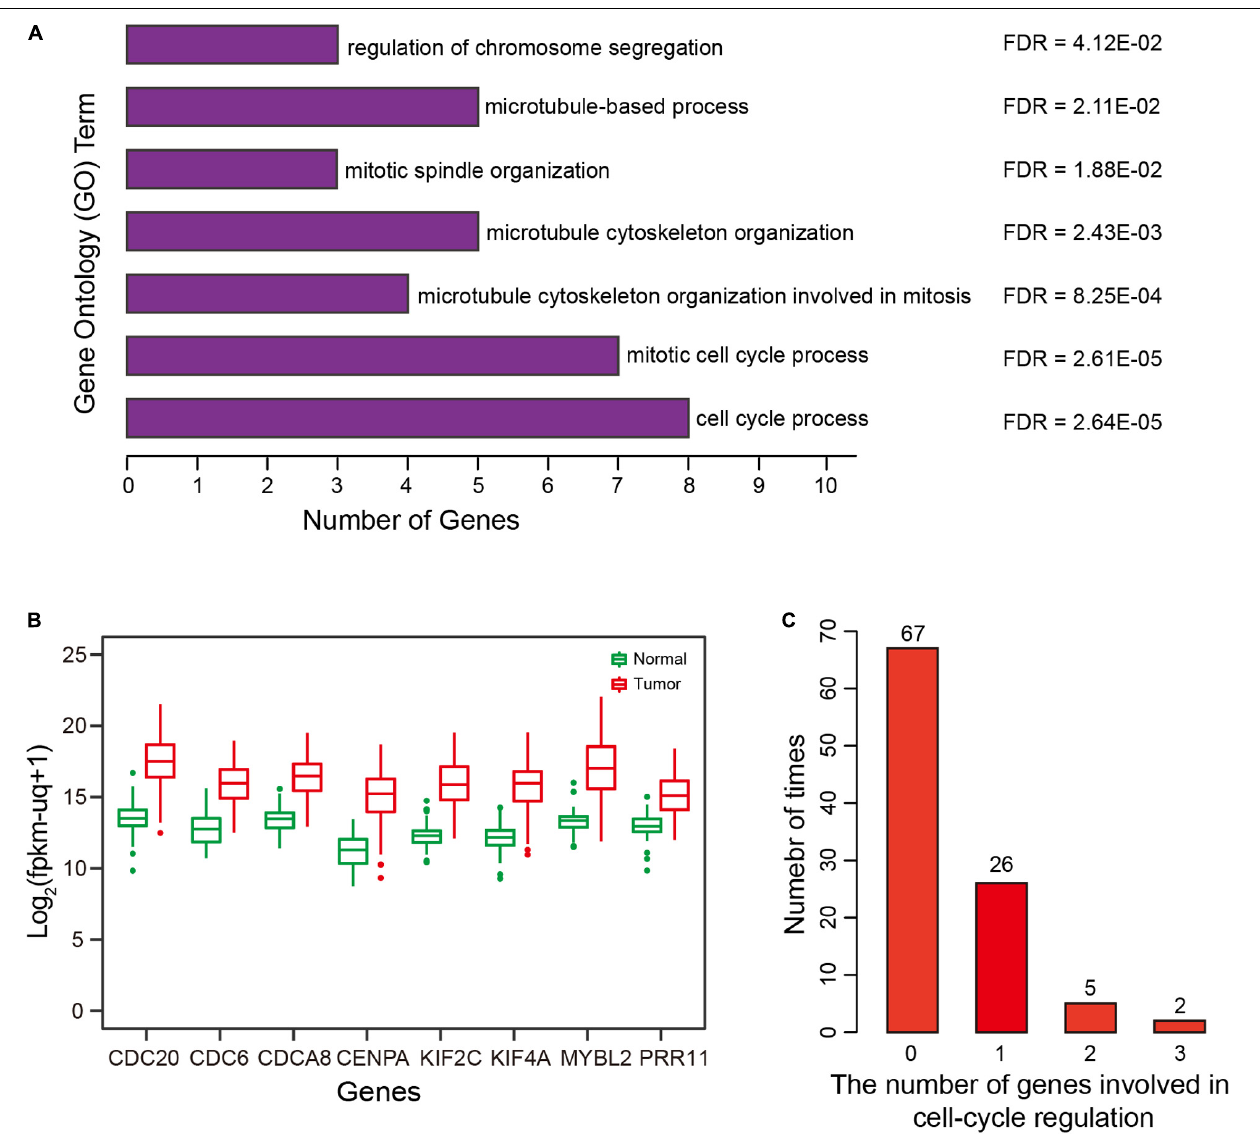
FIGURE 6 | Correlation and Gene Ontology (GO) enrichment analysis. (A) GO terms enriched for the top 10 genes significantly and positively correlated with risk scores of the prognostic signature. (B) Expression of eight genes by HCCs and normal controls. (C) Distribution and number of genes involved in cell cycle regulation, for 100